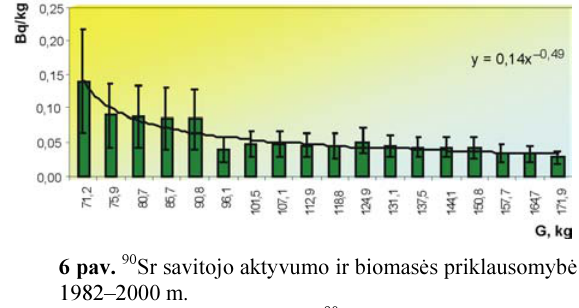
Fig. 5. Relationship between